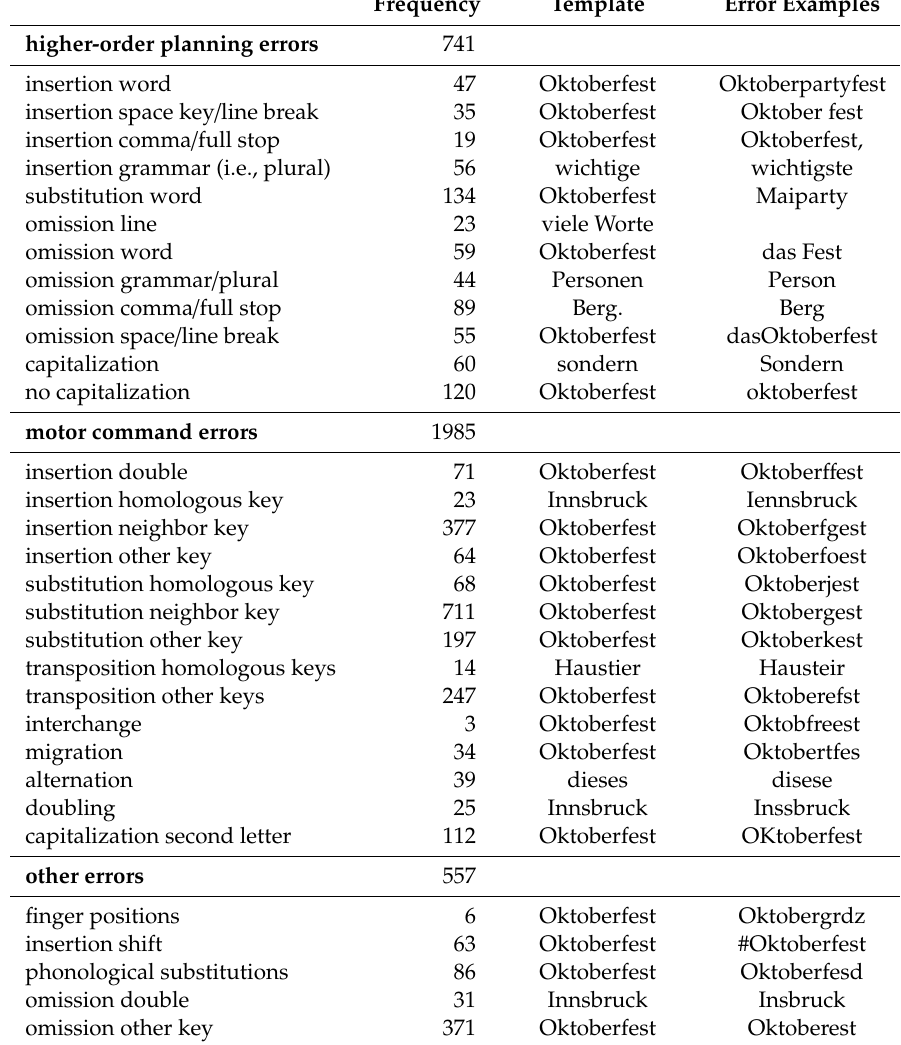
Table A1. Description and frequencies (sum over participants) of reported errors separately for the di ff erent error types and their subcategories. The templates included 411 words / 2741